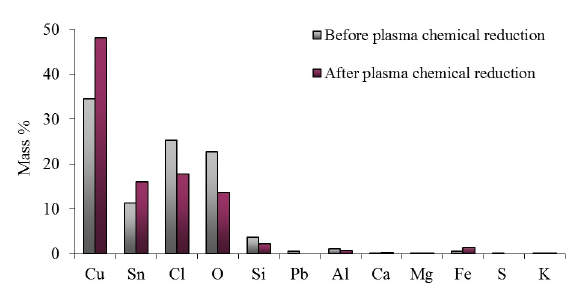
Figure 6: Results of EDX analysis, samples from Process